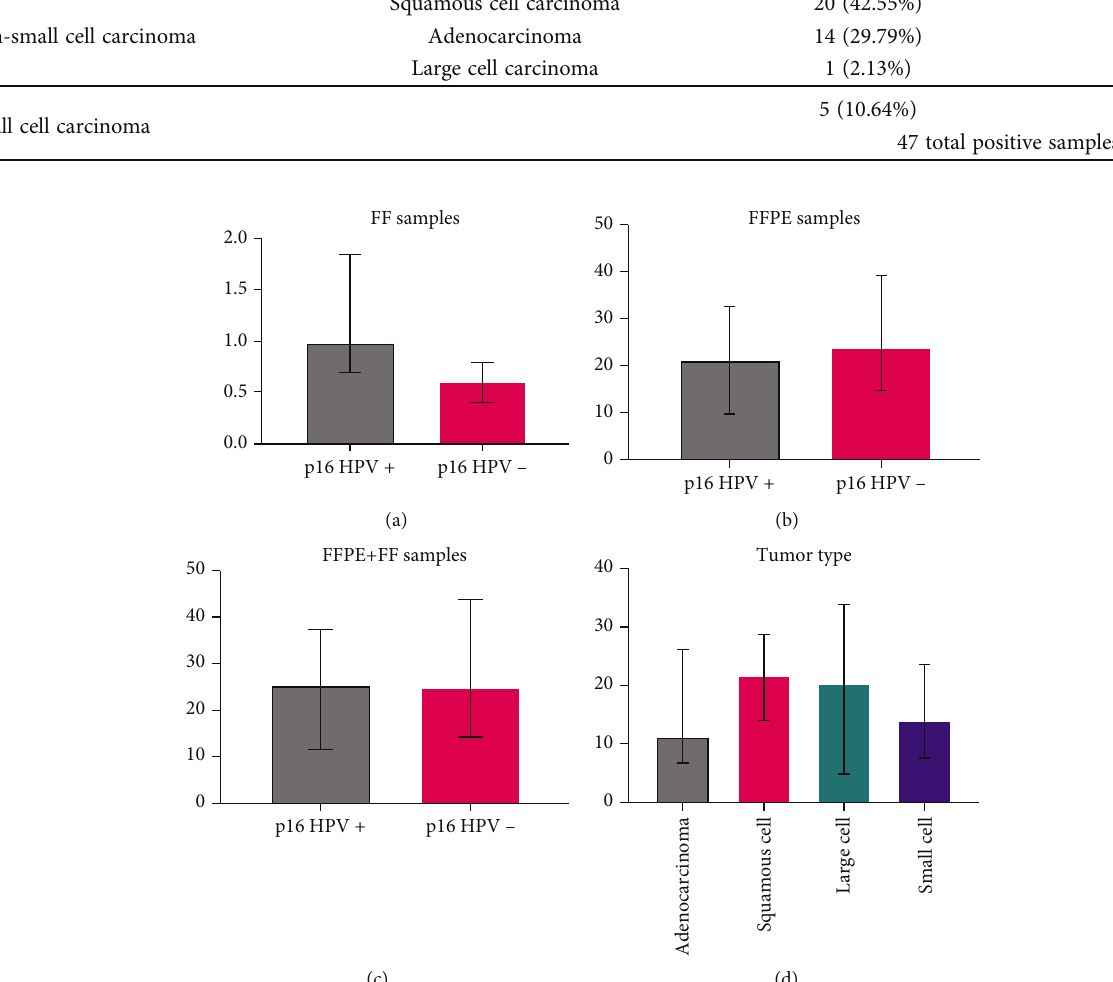
Table 1: Histopathological classi fi cation of all FFPE and FF samples and HPV type detection. Tumor type